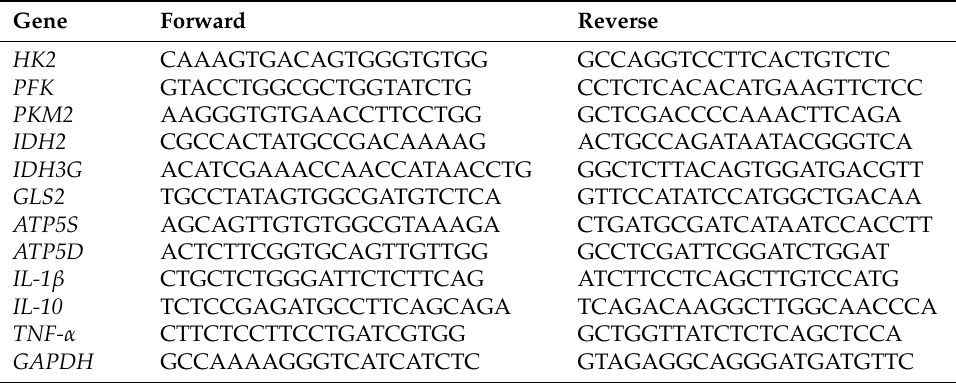
Table 1. PCR primer sequences used for real-time